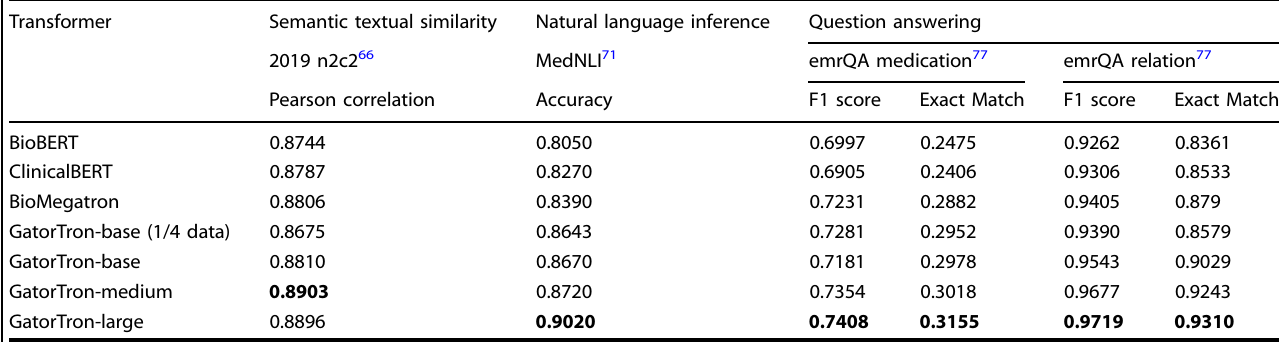
Table 2. Comparison of GatorTron with existing biomedical and clinical transformer models for semantic textual similarity, natural language inference, and question answering.